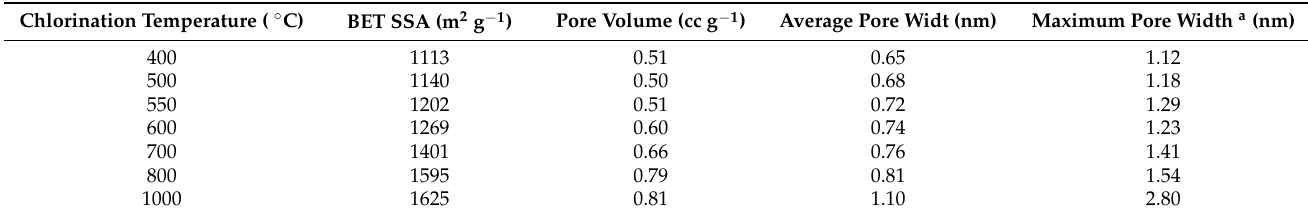
Table 3. CDC porosity measurements using the Ar gas sorption technique. Reprinted 2008 from [88] with permission from the American Chemical Society.